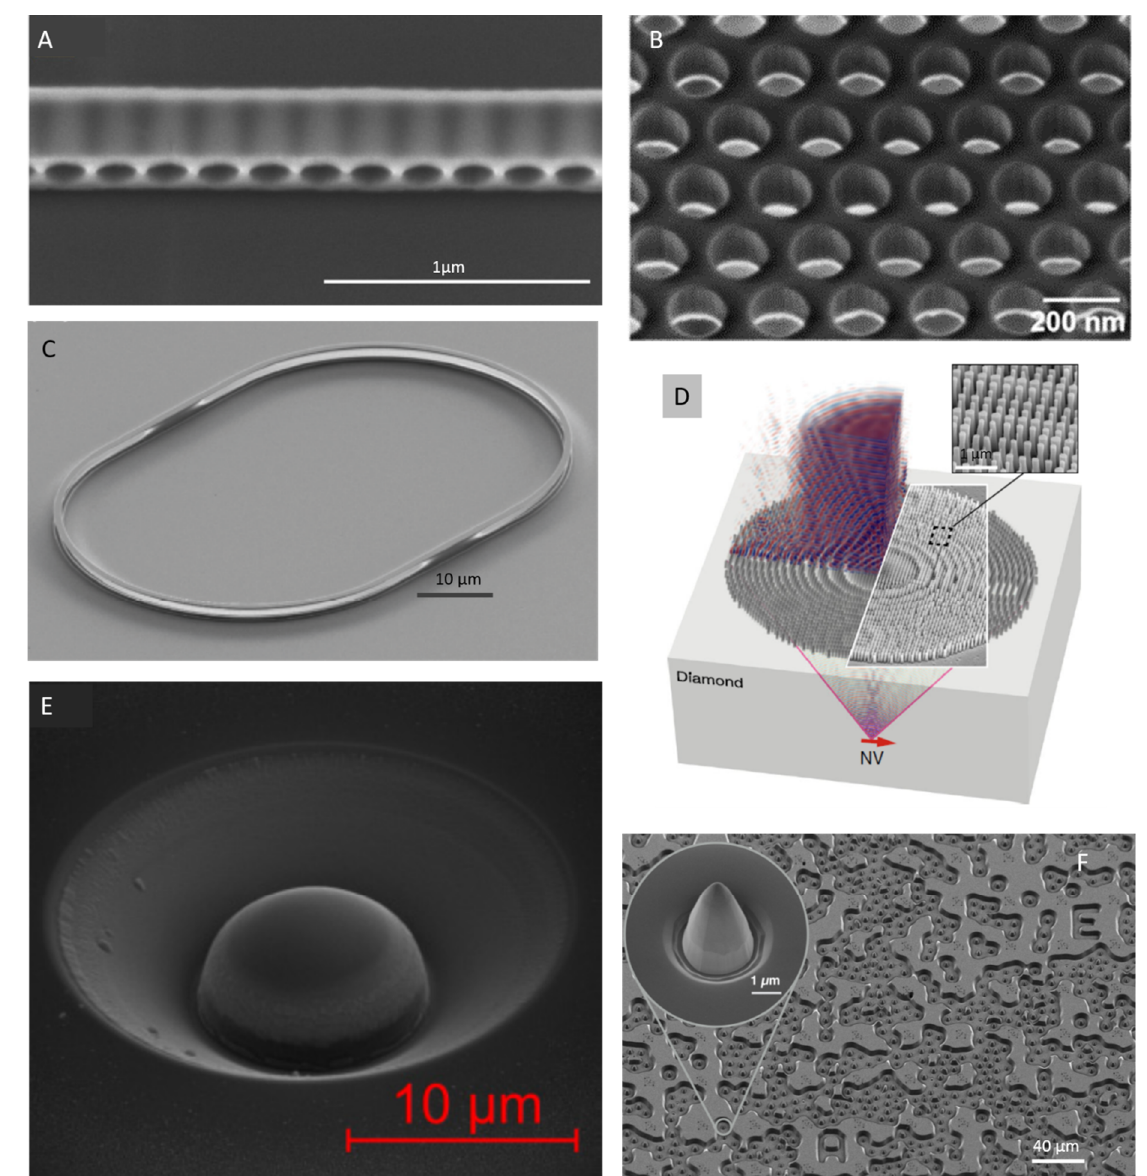
Figure 2. Scanning electron microscopy images ( A – C ) of different photonic components realized using lithography and dry etching processes: ( A ) rectangular nanobeam photonic crystal cavities (side view). Reprinted from Ref. [34], with